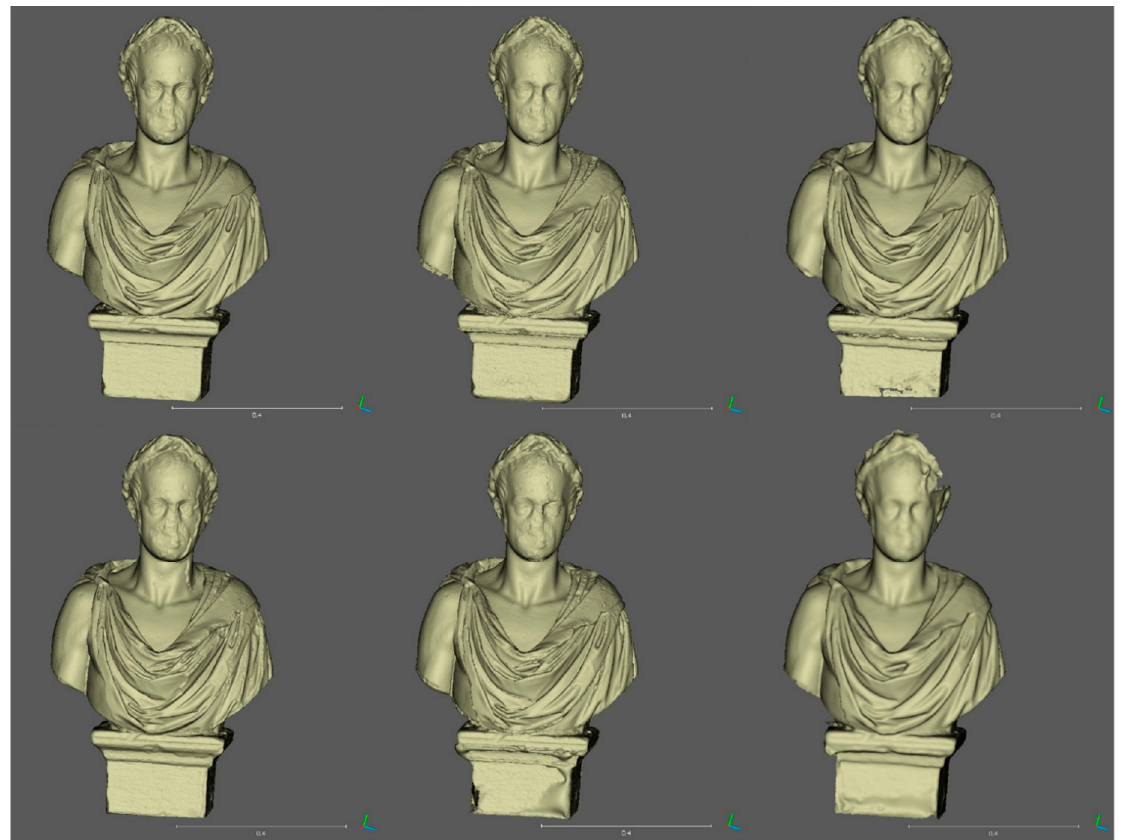
Figure 11. Untextured meshes of the stone bust from dataset 6 (from left to right, and from top to bottom): F6 SR, AMP, FZA, ARP, VCM, R3D.